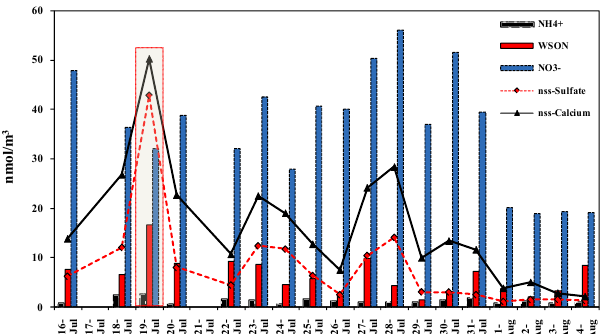
Figure 2. Temporal variation in nitrogen species and nss-SO 2 − and nss-Ca 2 + concentration in coarse particles ( D a > 2µm) over the tropical North Atlantic atmosphere. The frame defines the air mass back trajectory with dust mixed with anthropogenic sources (19 July